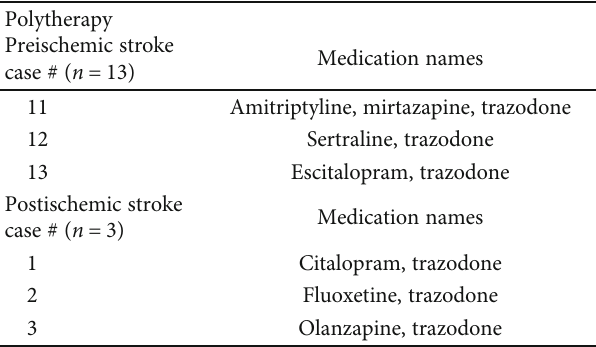
Table 1: Frequency of psychotropic medication use. Table 1: